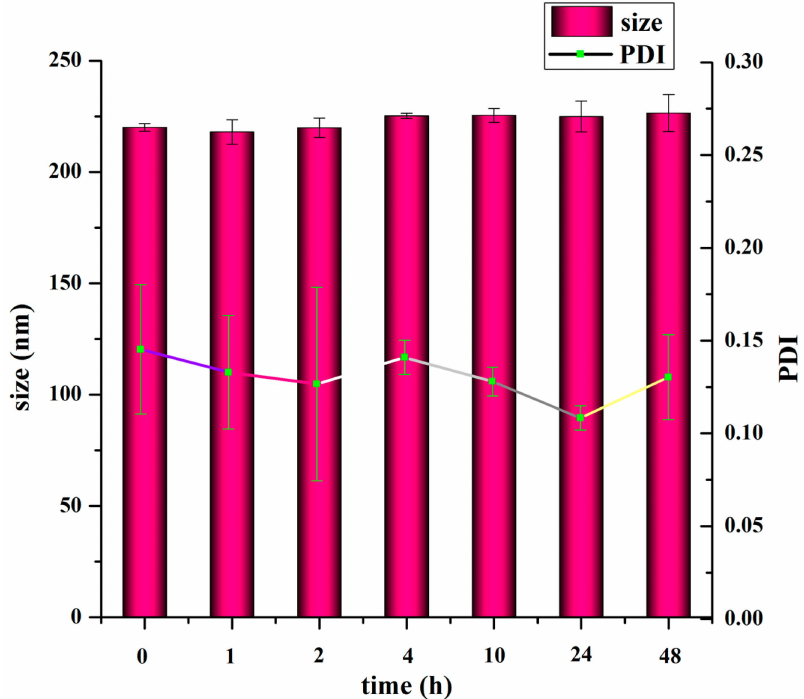
Figure 6. Size and PDI of nanoparticles during 2 days of incubation at 37 ˝ C in Hepes (pH 7.4).